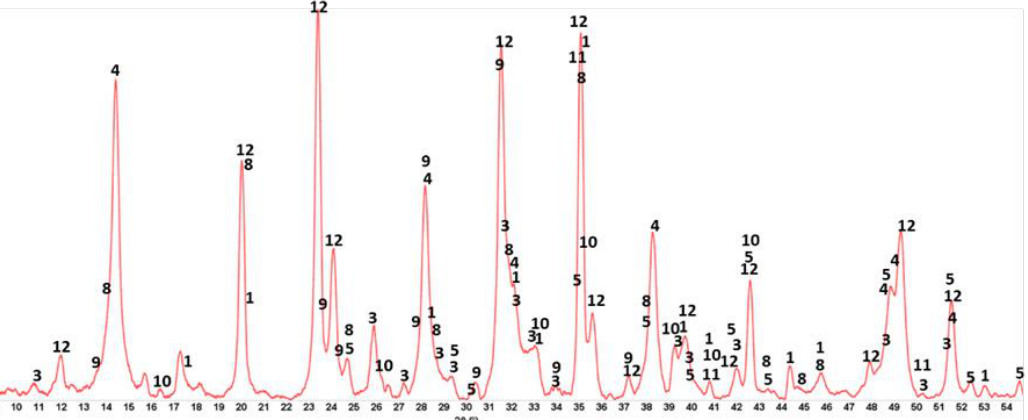
Figure 37. XRD pattern for 250 °C-autoclaved 87/13 ratio composite: 1-katoite (00-024-0217/01-077- 0240/01-084-01354/01-074-9779); 3-hydroxyapatite (04-016-1647/04-011-6221/01-074-9779); 4-boehmite (04-010-5683); 5-calcium carbonate (01-085-6719); 8-hydrosodalite (00-040-0102); 9-albite (01-089-6427); 10-mullite (04-016-1586); 11-silicon oxide (00-014-0654); and 12-dmisteinbergite (04-011-6236).